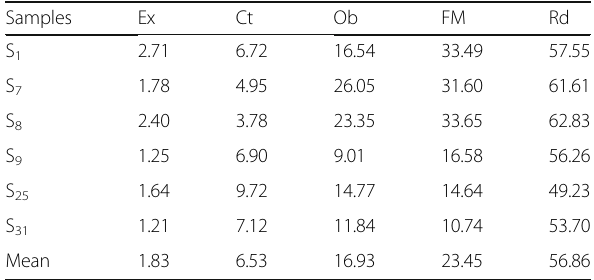
Table 9 Copper fractionation results (ppm)